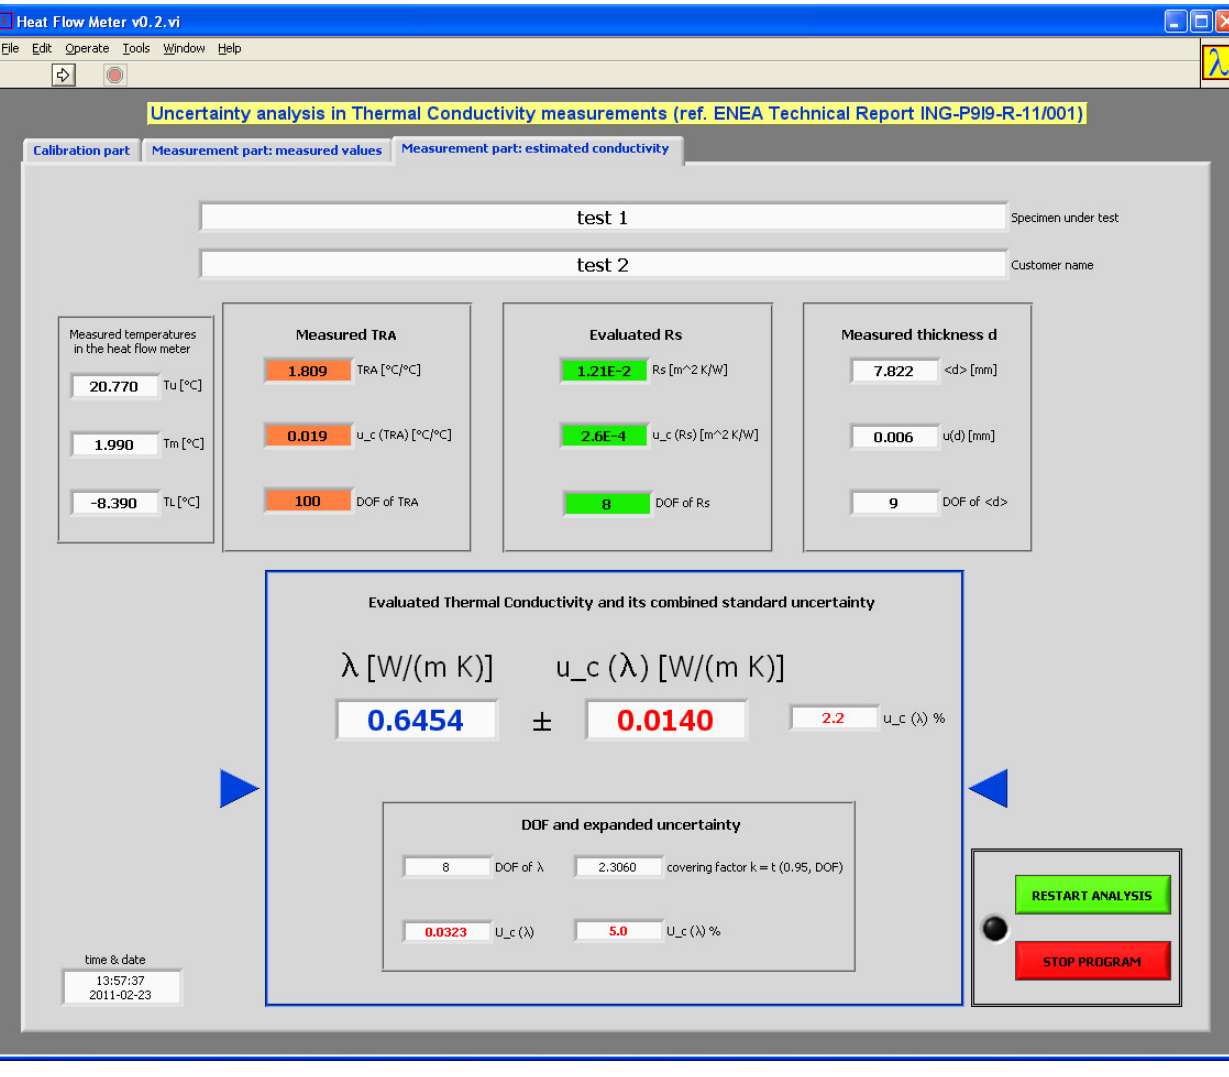
Fig. 9. (Color online) Software Snapshot – Sheet 2: estimated conductivity.